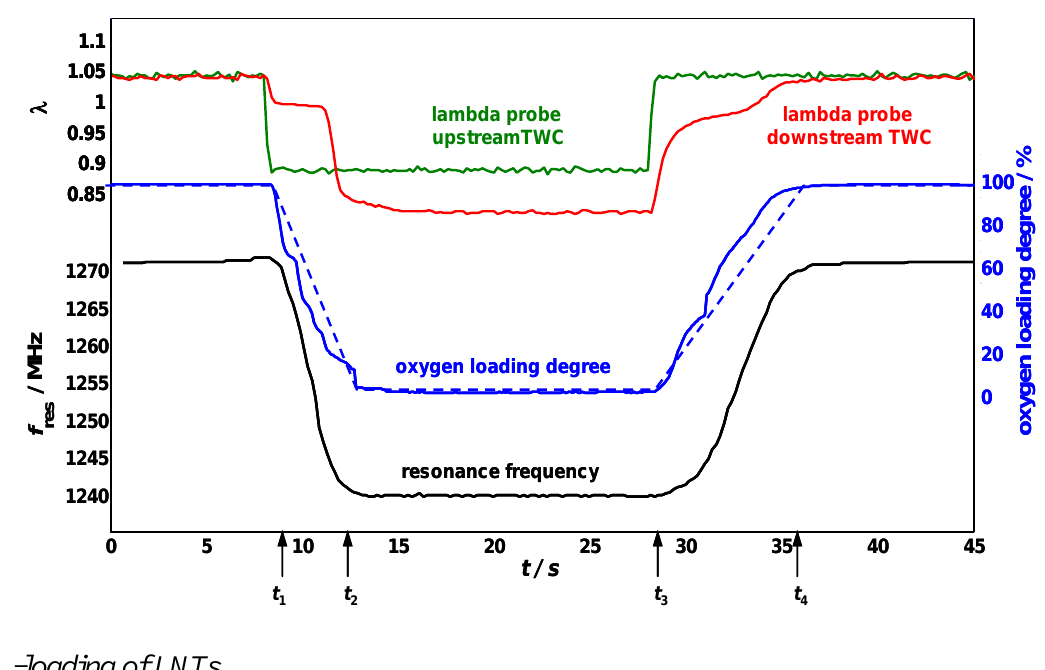
Figure 8. Lambda probe signals up- and downstream of the TWC (green rsp. red), resonance frequency ( f ) during oxygen loading and unloading (black), and measured res (blue) and roughly calculated (dotted blue) degree of oxygen loading. Recalculated, partly using data from